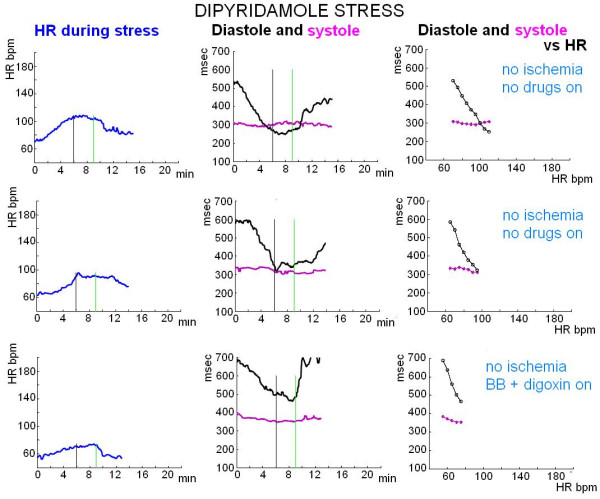
Dipyridamole stress echo (0.84 mg/kg in 6', accelerated protocol). Systolic (pink lines) and diastolic (black lines) times as a function of HR. Dipyridamole results in adenosine receptor-mediated systemic as well coronary vasodilatation, often accompanied by a reflex increase in heart rate. With moderate stress induced HR increase (up to 110–100 bpm, upper and middle panel) diastolic time critically shortens, equalling systolic time. With mild induced HR increase (up to 70 bpm, lower panel) diastole has longer duration.